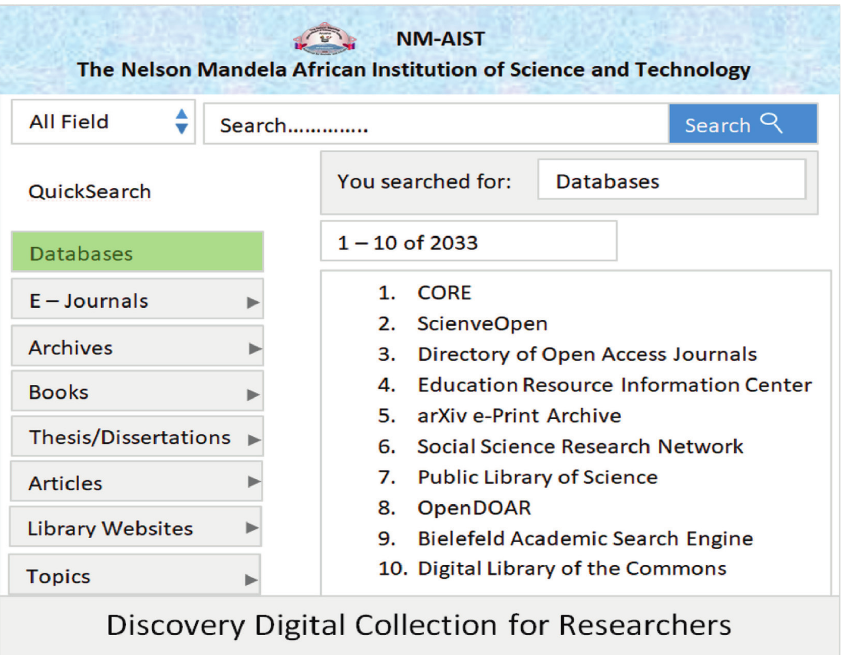
Figure 3: User-friendly digital library discovery system